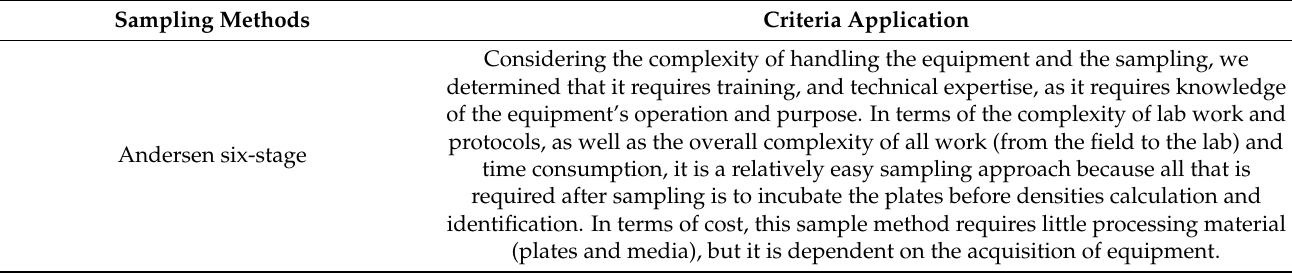
Table 2. Index of Scoring Criteria.